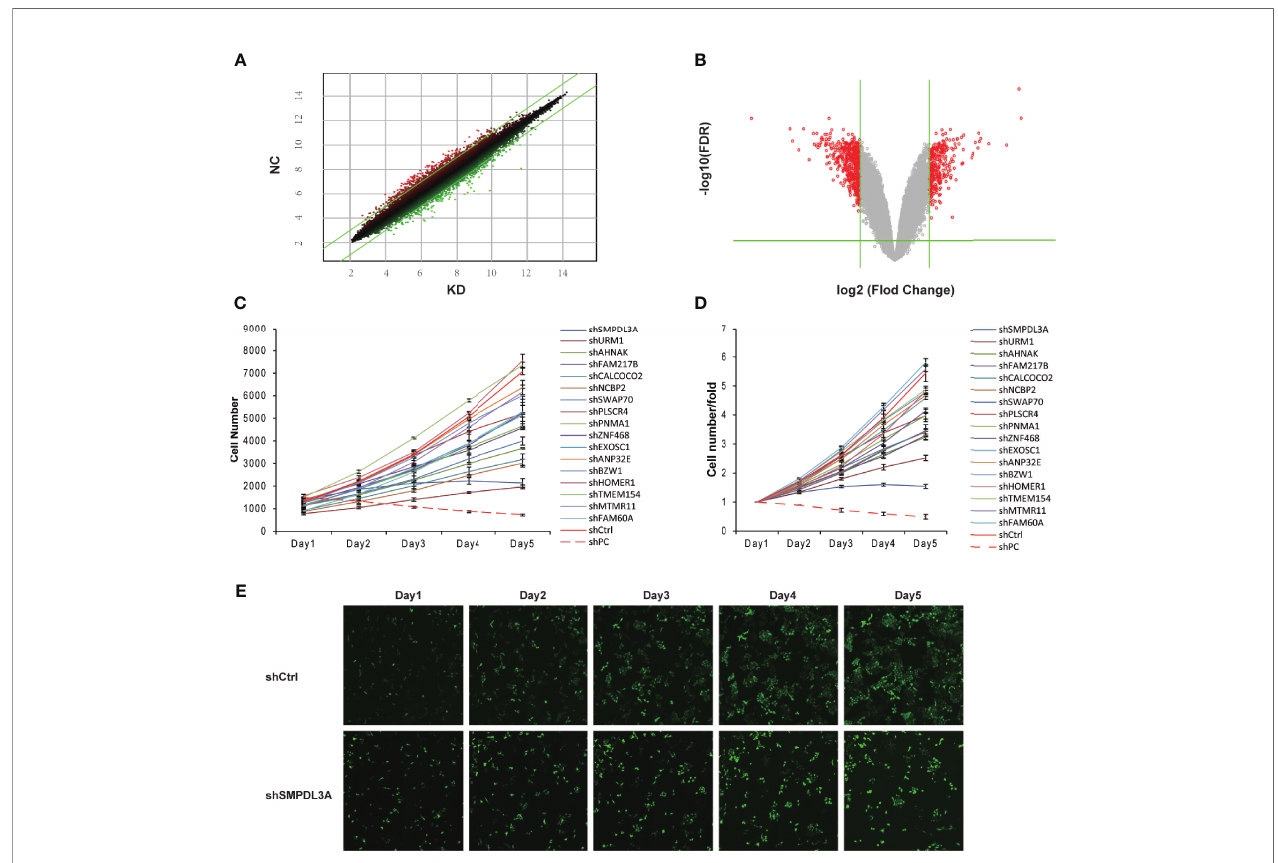
FIGURE 1 | Differential gene expression screening from Affymetrix expression pro fi le microarray after VDAC1 knockdown. (A) The scatter-plot of differential gene chip. (B) The Volcano Plot of differential expression pro fi les of gene. (C, D) Proliferation of corresponding differentially expressed genes was detected on the HCS platform. Knockdown of SMPDL3A signi fi cantly inhibits HCC cell proliferation. Positive control for PC, Negative control for Ctrl. (E) shSMPDL3A signi fi cantly suppressed